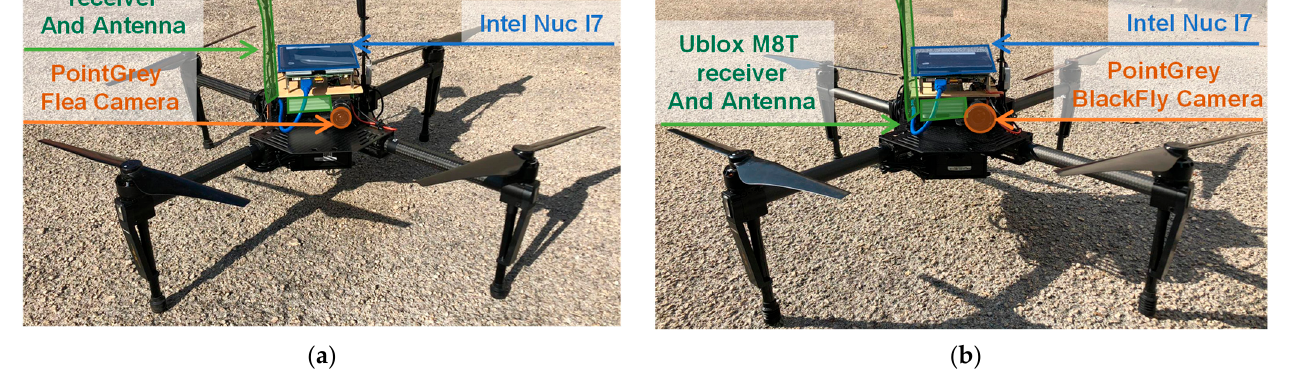
Figure 20. ( a ) Eagle and ( b ) Athena setup.